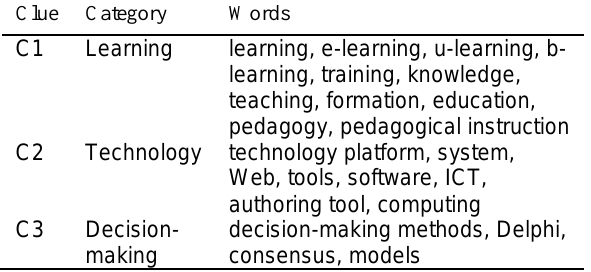
Table 4. Category